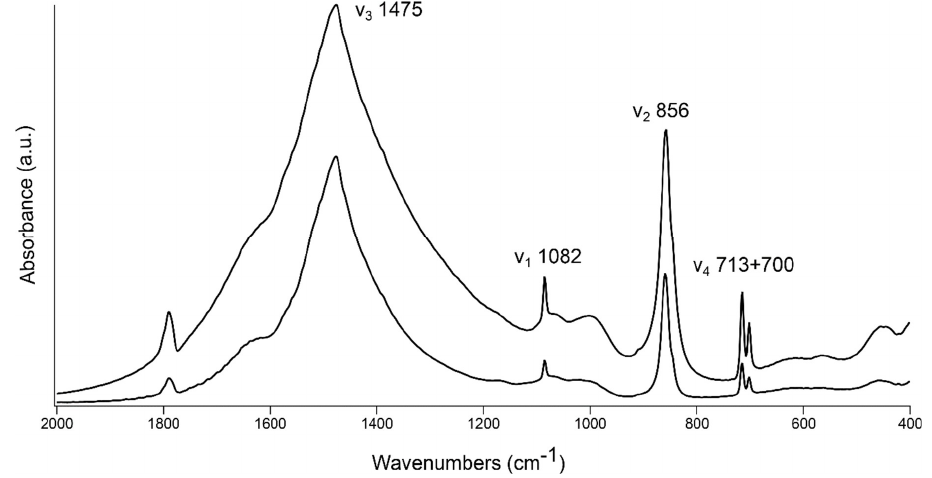
Figure 1. FTIR spectra of aragonite formed in boiling water. Upon increased grinding (lower spectrum), absorptions become narrower (a.u.: arbitrary units; spectra normalized to the ν 3 absorption of aragonite).